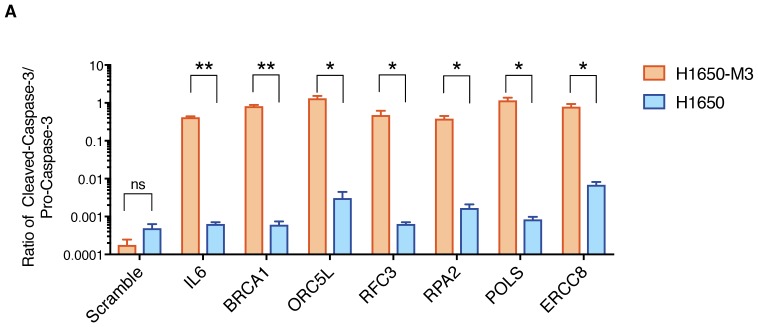
Quantification of apoptosis-mediated increase in lethality in H1650-M3 and H1650.The chart depicts quantification of relative amounts of Cleaved-caspase-3 between H1650-M3 and H1650 from the immunoblots indicated in Figure 1F. Levels of intensity of each band were quantified using imajeJ32 software and is represented as a ratio to Pro-Caspase-3. The data represent mean ± SD from two independent experiments. p-value *<0.05, **<0.005, unpaired t-test.